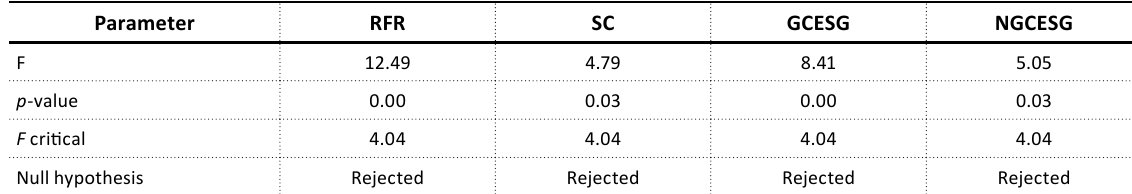
Table C2. ANOVA test of the differences between developed countries and developing and emerging countries Parameter RFR GCESG NGCESG